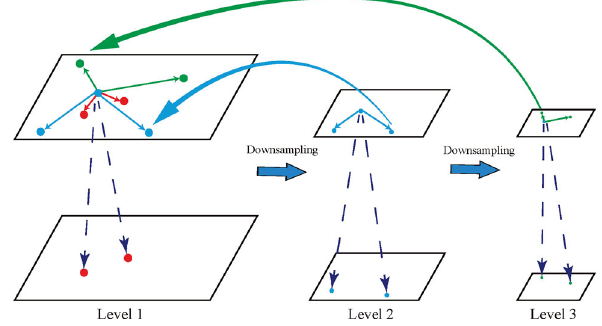
Fig. 2 Label set